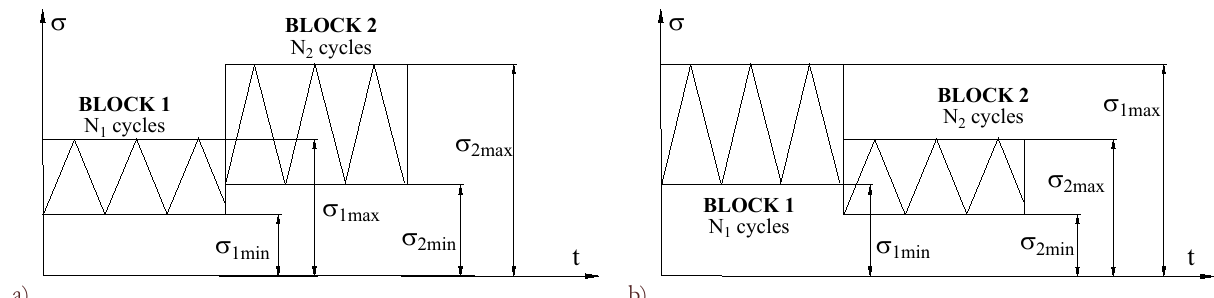
Figure 1: The sequence of blocks according to [8]: a) Lo-Hi, b)